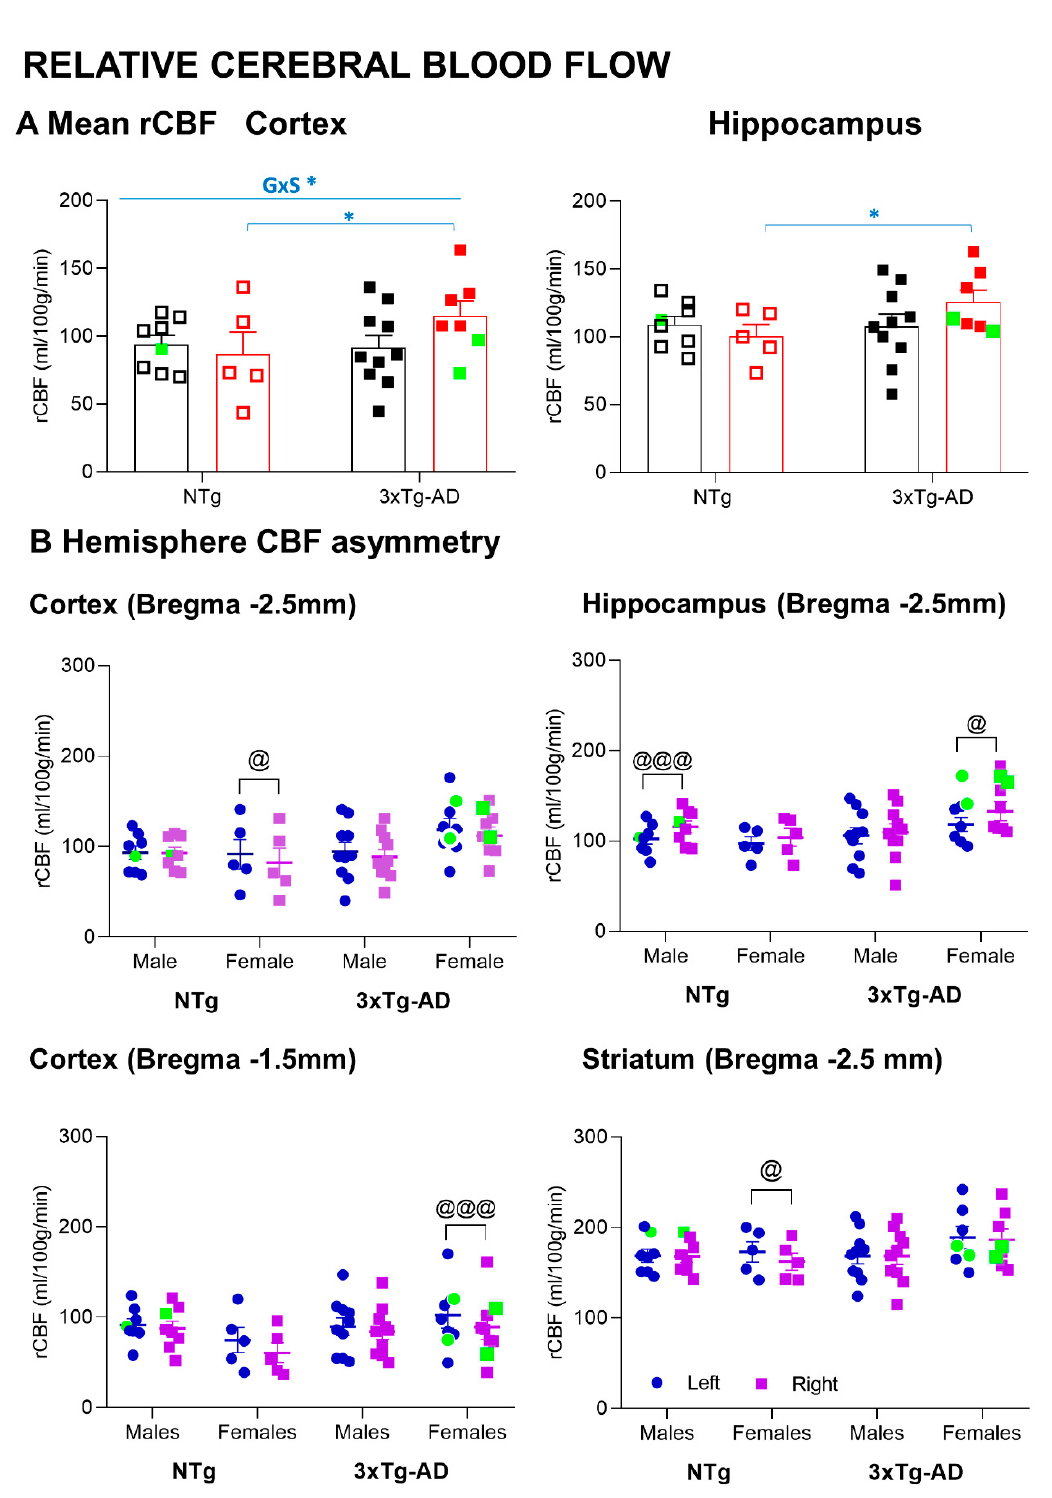
Figure 6. MRI-ASL—relative cerebral blood flow. ( A ) Mean relative blood flow in cortex and hippocampus. ( B ) Hemisphere relative cerebral blood flow asymmetry. Results are the mean ± SEM. Bars illustrate the genotype groups, as indicated in the abscissae. Symbols are used to illustrate individual values of males (black, left panel) and females (red, right panel). Left hemisphere: blue; right hemisphere: purple. In green: the no-survivors. Genotype (G) and sex (S) effects and GxS interaction were analyzed by 2x2 factorial ANOVA analysis, * p < 0.05 (above line). Student t -test comparisons: * p < 0.05 vs. the corresponding NTg group; Paired t -test in asymmetry between right/left hemispheres: @ p <0.05, @@@ p < 0.001.